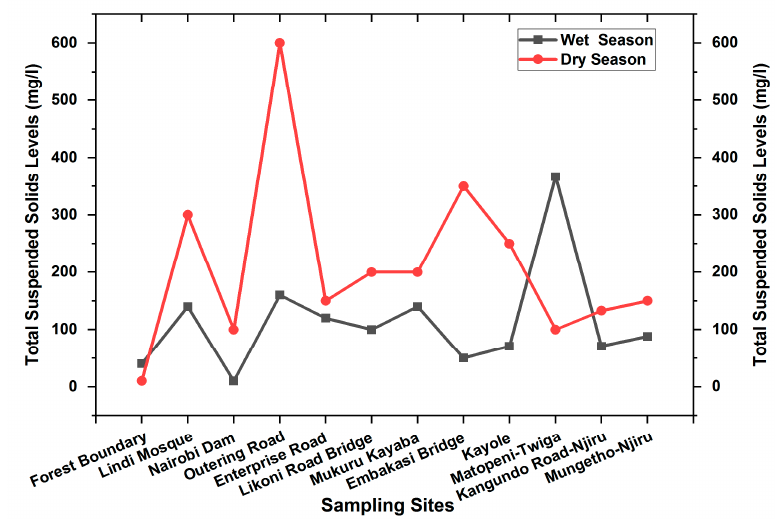
Figure 11. Total suspended solids levels of Ngong River measured between April and August 2021. Except for Ngong Forest Boundary, all other sampling stations had total suspended solids levels above the NEMA maximum permissible level for drinking water of 30 mg/L.